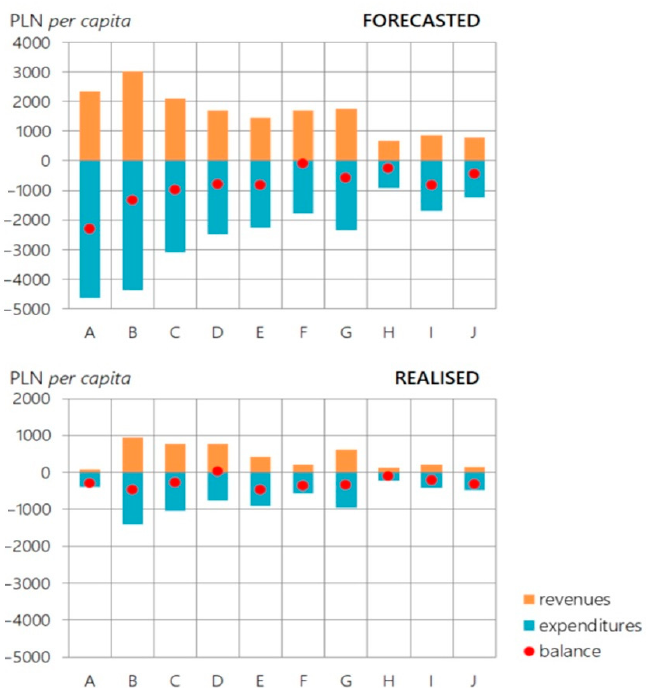
Figure 2. Structure of forecasted and realized revenues and expenditures of communes per capita by types of communes as a result of local plans enacted, for the year 2019. Source: based on unpublished data of the Ministry of Development and Statistical Office of Poland.